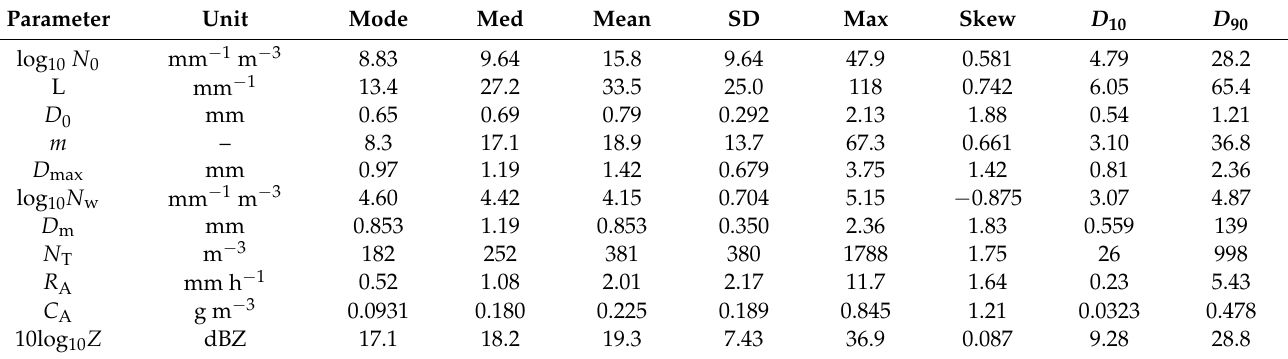
Table 4. Statistical values of gamma, normalized, and integrated particle size distribution (PSD) parameters. ρ b = 1.25 × 10 3 kg m − 3 and ρ p = 2.50 × 10 3 kg m − 3 were assumed for the estimation of R A .